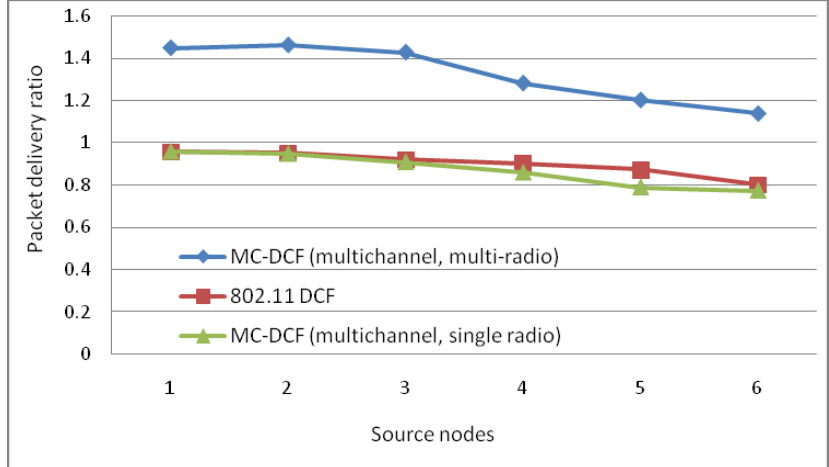
Figure 13. Delivery impact comparison with one-many communications at sink